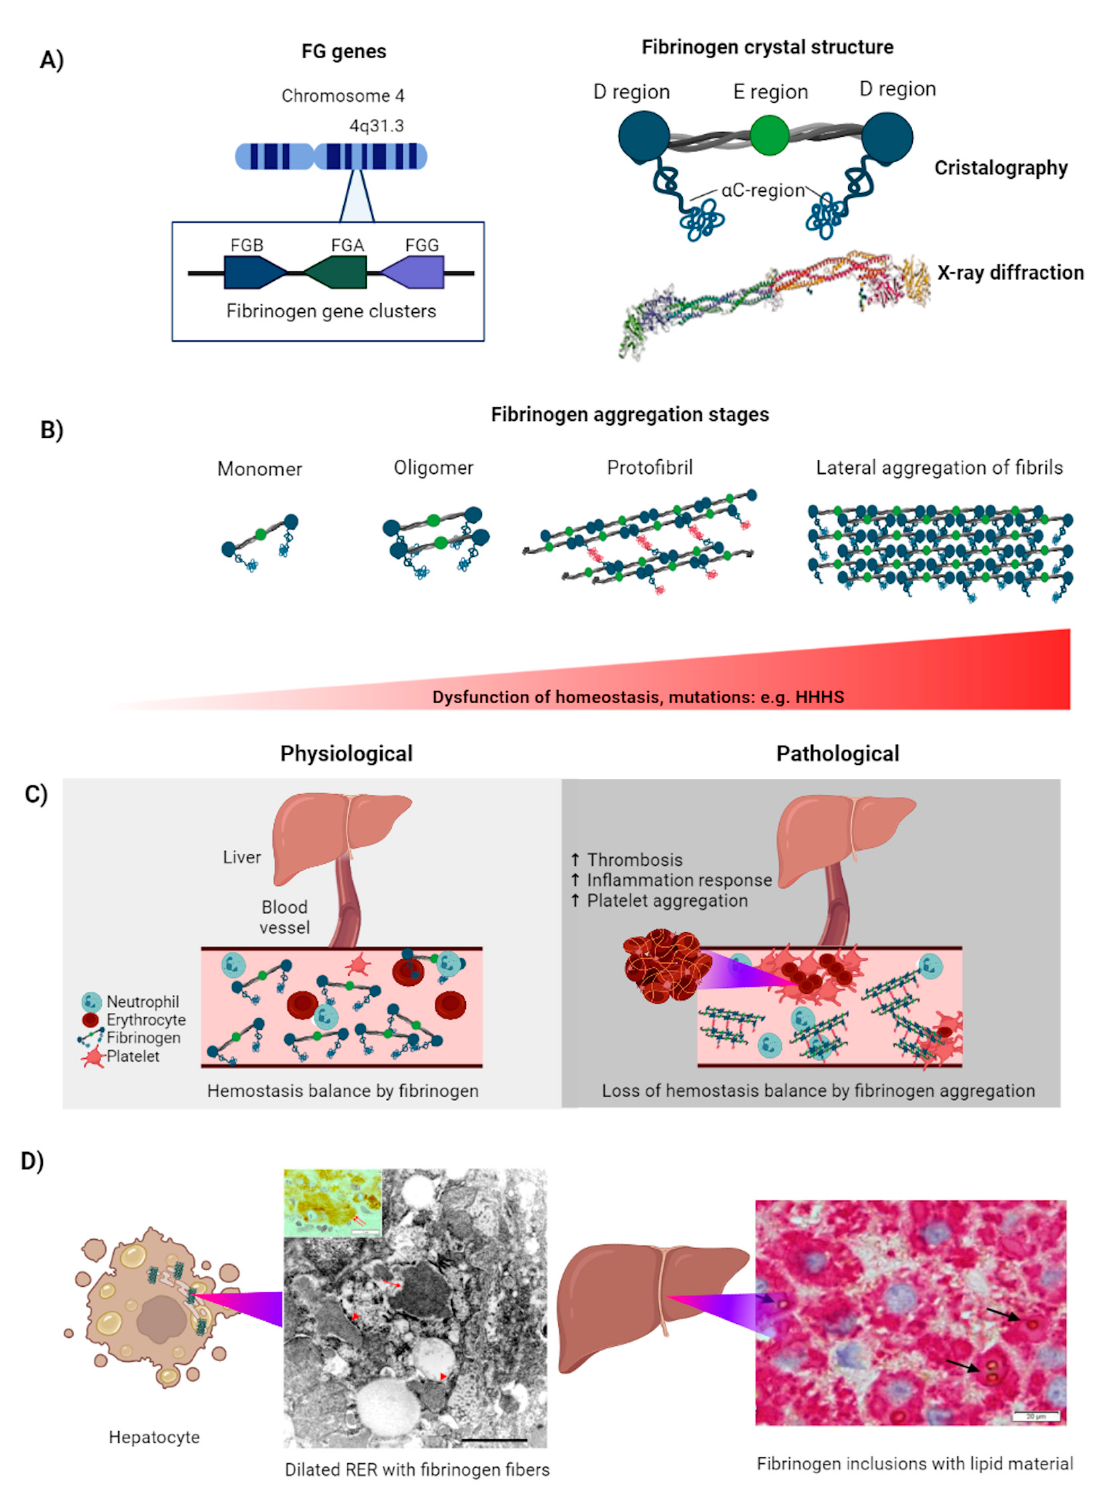
Figure 3. FG misfolding and aggregation in HHHS. ( A ) Left: FG gene coding for FG on chromosome 4 [136]. Right: Native structure of FG and its three-dimensional structure (PDB 3GHG). ( B ) Aggregation states of FG. ( C ) FG activity under physiological conditions (left) and alterations in its function under HHHS (right). ( D ) Histopathological damage caused by HHHS. Left: Electronic microscopy (8000×) of hepatocyte showing dilated rough ER and aggregation of FG into tubular structures or elongated fibers. Image taken from Callea et al. (2021) [100]. Right: Section of liver tissue from a patient with HHHS. Hepatocytes contain FG immunoreactive inclusions (red) with apolipoprotein B (arrows) positive lipid material (original magnification of 60×). Image taken from Callea and Desmet (2021) [137].